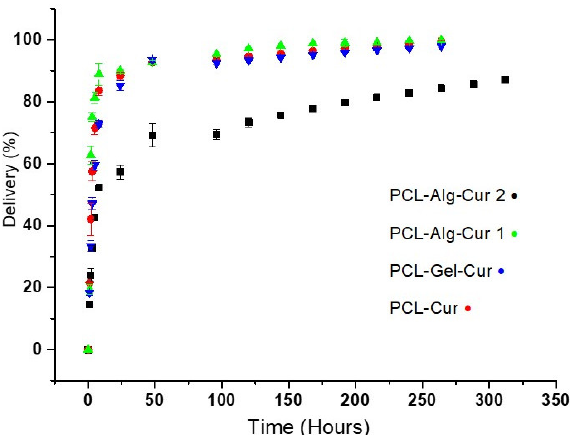
Figure 6. Release profile of curcumin (Cur) in vitro from uniaxial and coaxial nanofibers.